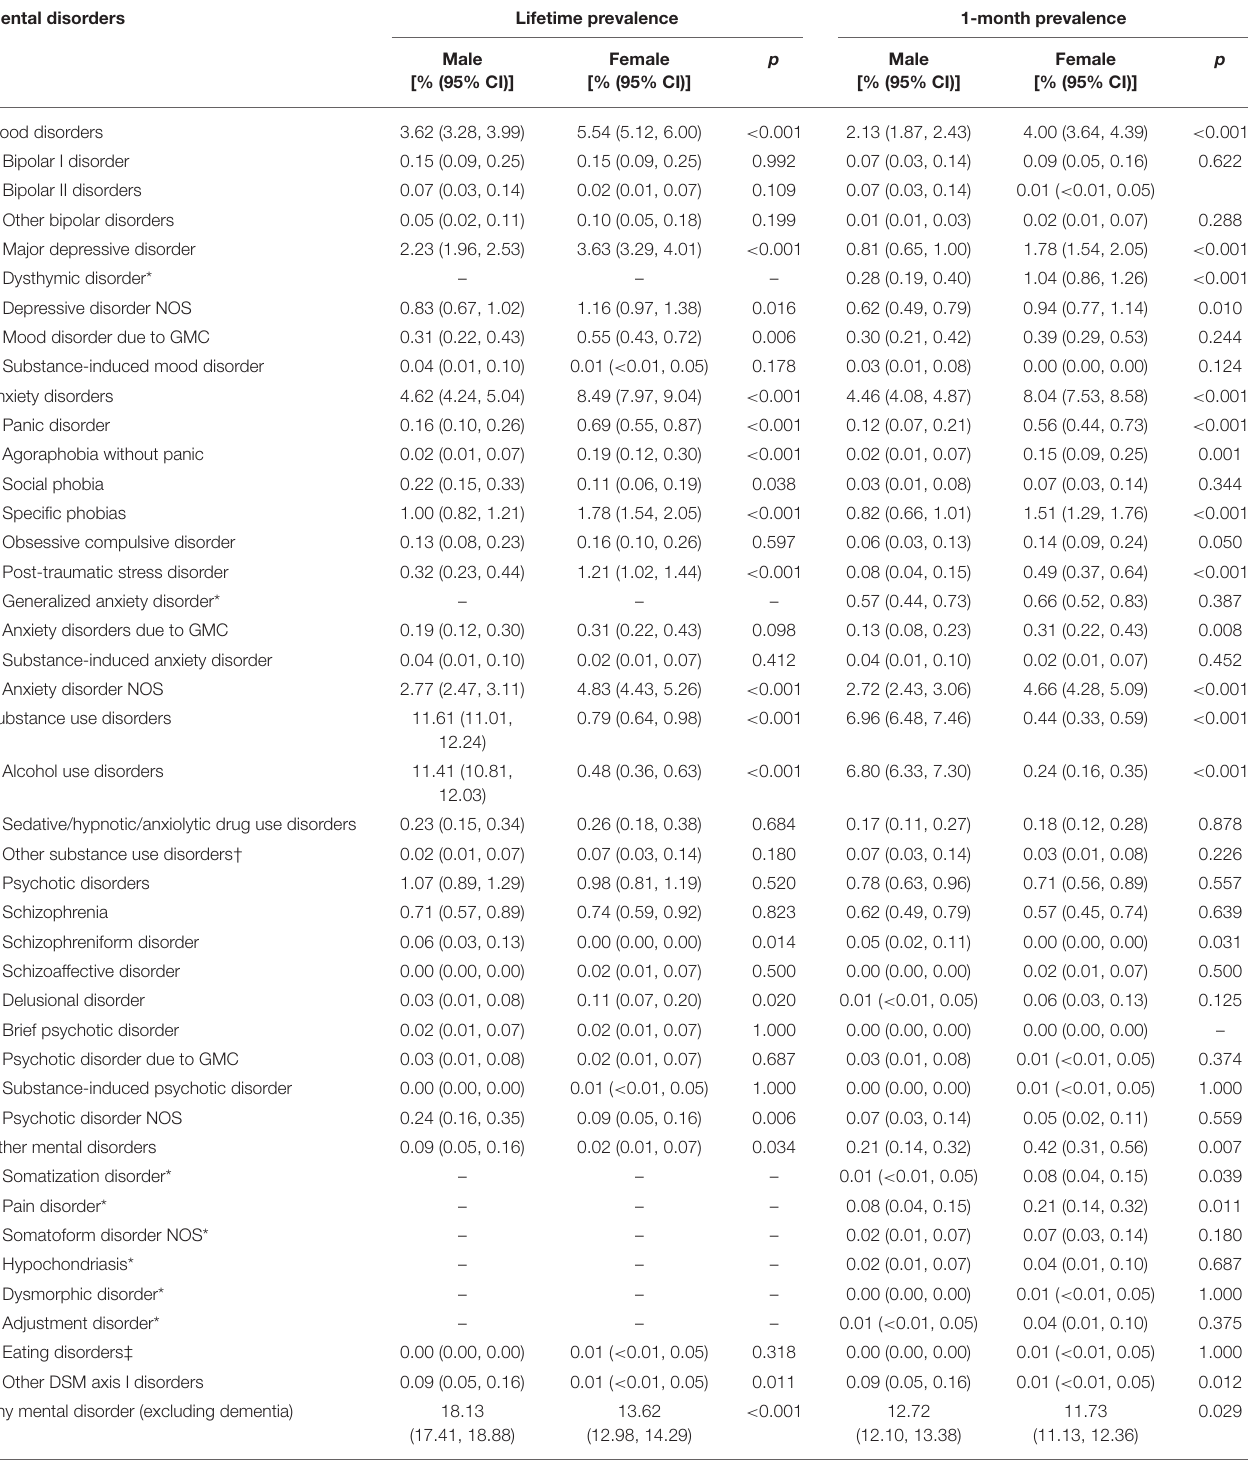
TABLE 3 | Weighted lifetime and 1-month prevalence of mental disorders by gender in Hebei province, China ( n =